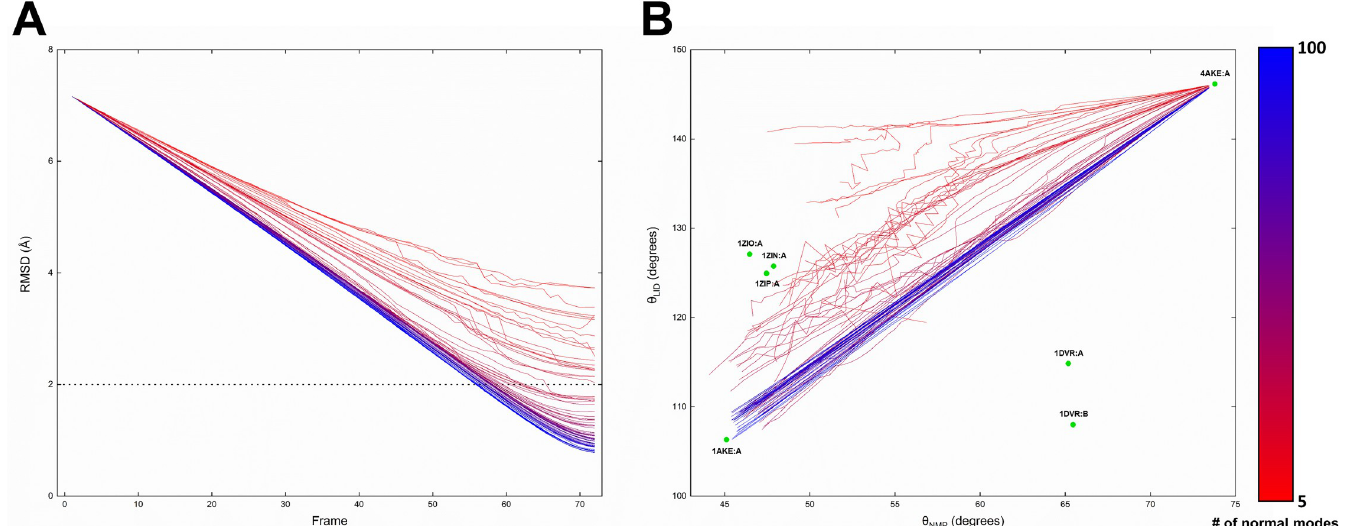
Fig 7. The pathway ensemble for ADK generated by ICONGENI. The ICONGENI transition pathways that make up the pathway ensemble are colored according to the lowest normal modes (from 5 to 100) used in the simulation (red to blue color scheme). (A) Convergence of the pathway ensemble. The RMSD values of each path relative to a final state are measured. The black dotted line represents the corresponding experimental resolution of ADK. (B) Projection of the pathway ensemble onto θ NMP − θ LID space. The green points show the positions of experimental structures on θ NMP − θ LID space. 4AKE:A and 1AKE:A indicate the open and closed states of ADK, respectively. 1ZIN:A, 1ZIO:A, and 1ZIP:A (1DVR:A, and 1DVR:B) indicate experimental structures at the NMP C state (the NMP O state).